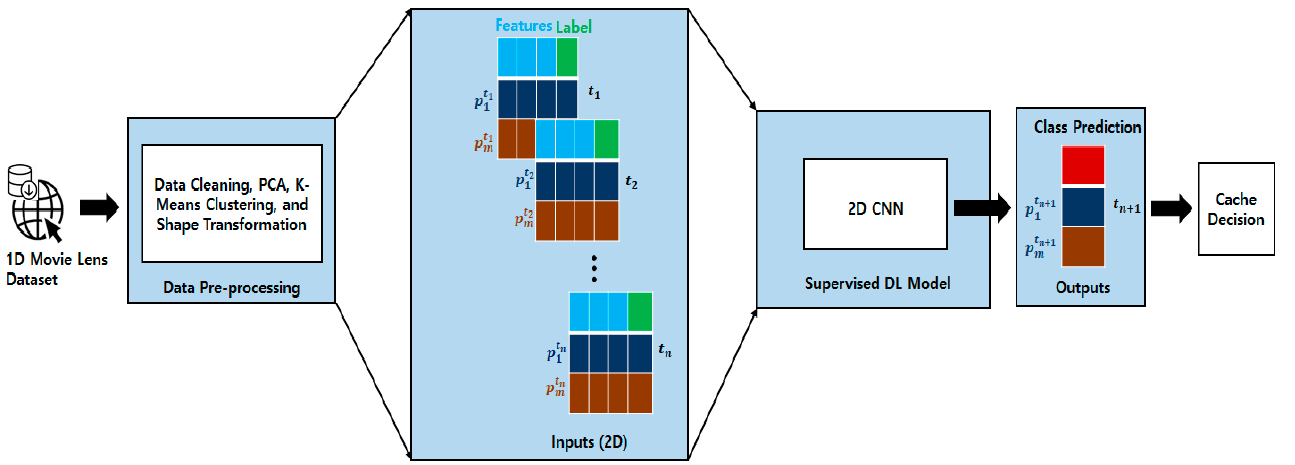
Figure 3. The overview of the DLCC policy to get the popular content in terms of popular